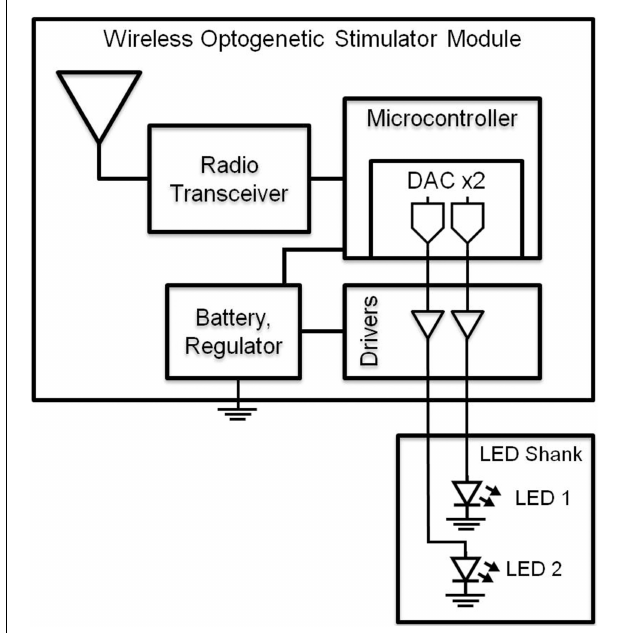
FIGURE 1 | Block diagram of wireless optogenetic stimulator. A microcontroller containing two digital to analog converters (DAC) allows independent control of two blue LEDs.